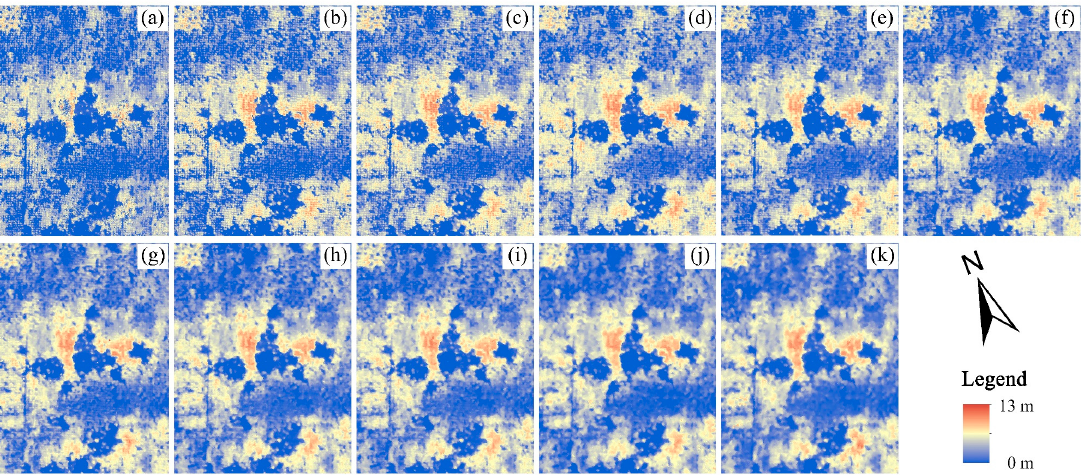
Figure 3. CHMs at different flight altitudes. (( a ): 40 m; ( b ): 60 m; ( c ): 80 m; ( d ): 100 m; ( e ): 120 m; ( f ): 140 m; ( g ): 160 m; ( h ): 180 m; ( i ): 200 m; ( j ): 220 m; and ( k ): 240 m). Table 1. UAV image acquisition and pre-processing parameters. Flight Altitude